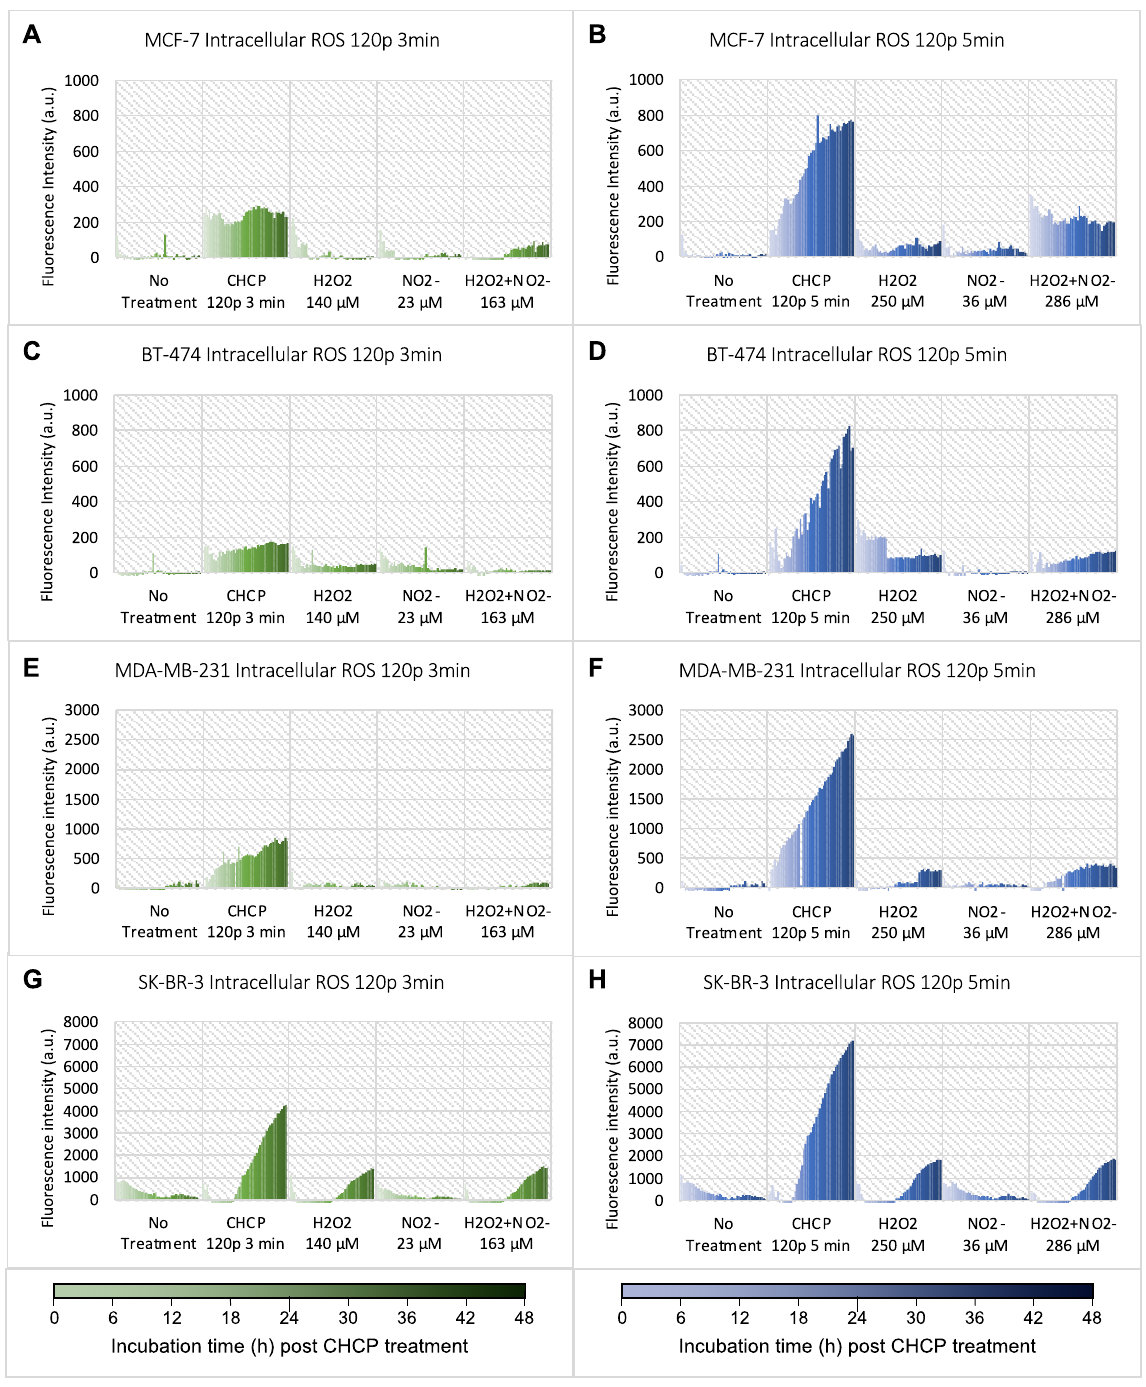
Figure 1. Intracellular ROS measurements of breast cancer cell lines at 0 – 48 h post CHCP treatment. H 2 O 2 and/or NO 2 − were used as positive controls. All cells were treated by CHCP at 120 p for 3 and 5 min. ( A , B ) Treated MCF-7 cells. ( C , D ) Treated BT-474 cells. ( E , F ) Treated MDA-MB-231 cells. ( G , H ) Treated SK-BR-3 cells.